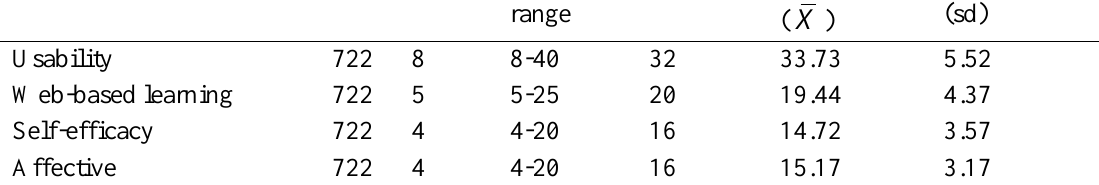
Differences in Using the Web for Common Web Activities Based on Gender